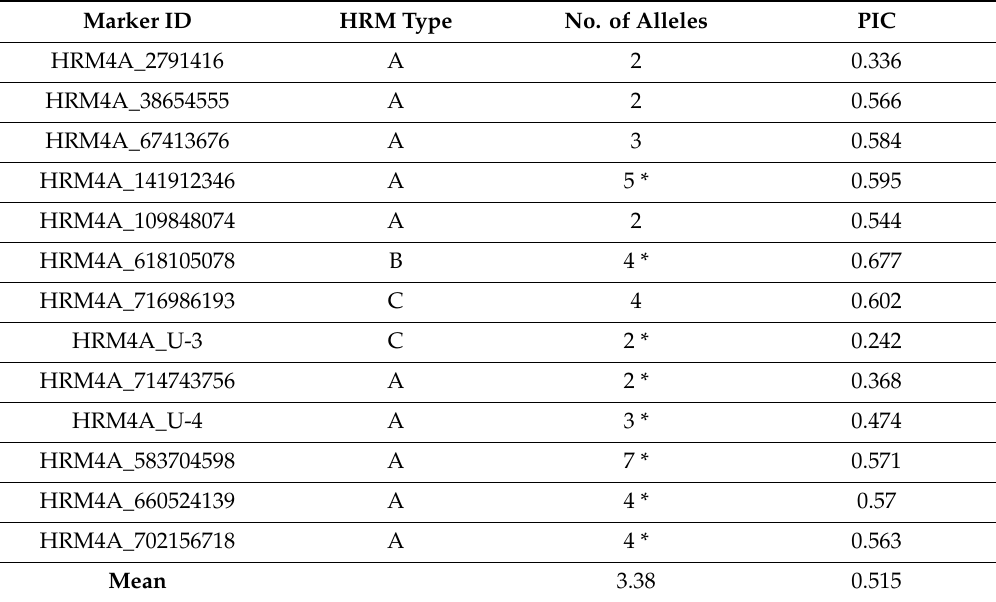
Table 5. Genetic parameters for the wheat chromosome 4A ISBP markers used in the variability